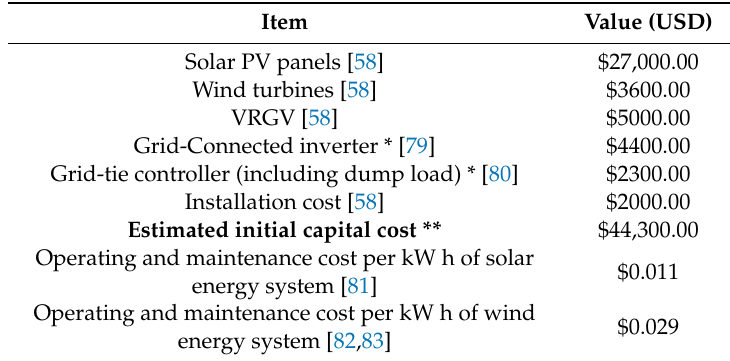
Table 11. Detailed cost of the system.